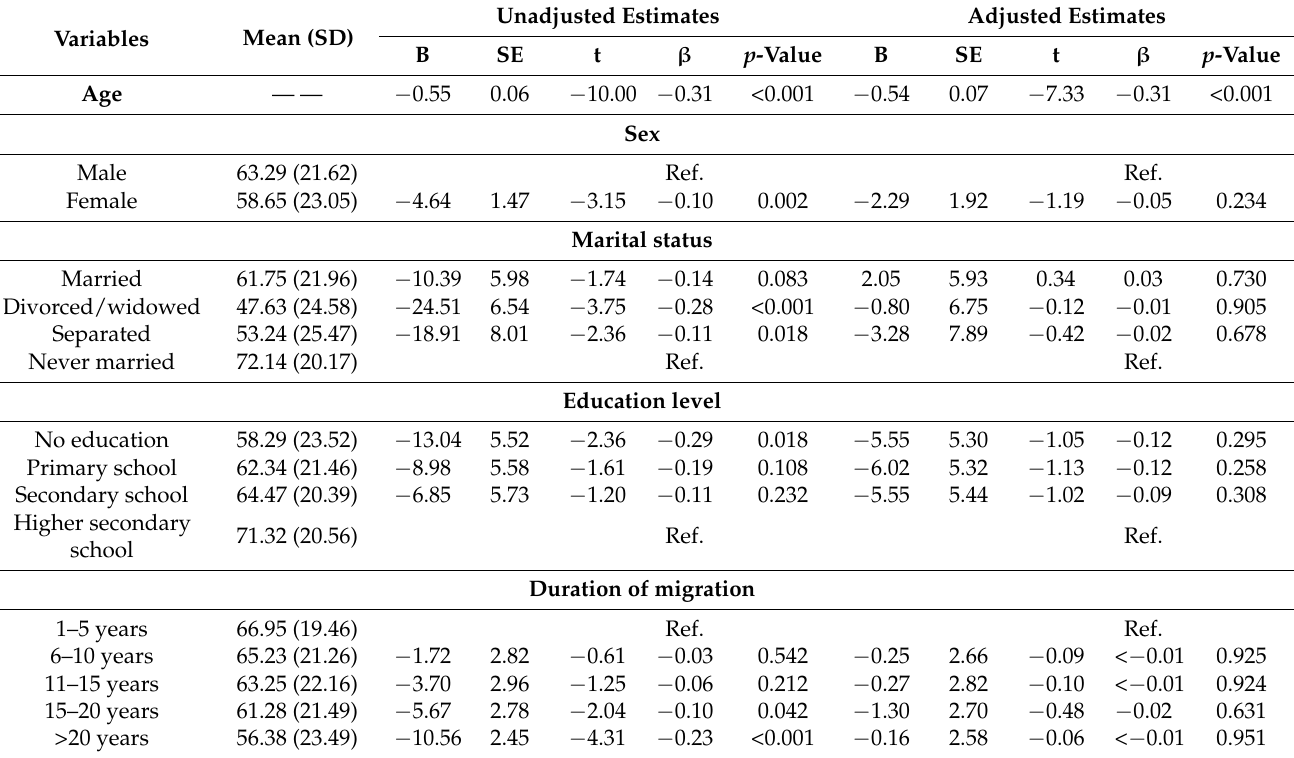
Table 4. Bivariate and multiple regression analyses by MCS